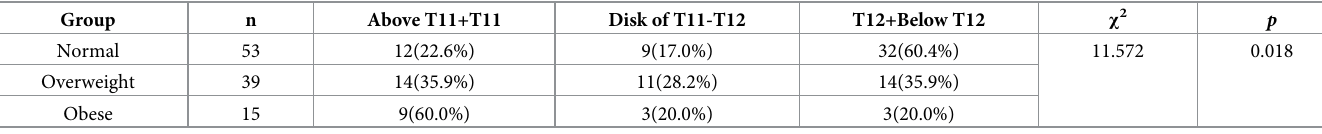
The difference between groups was tested by Fisher’s exact test.